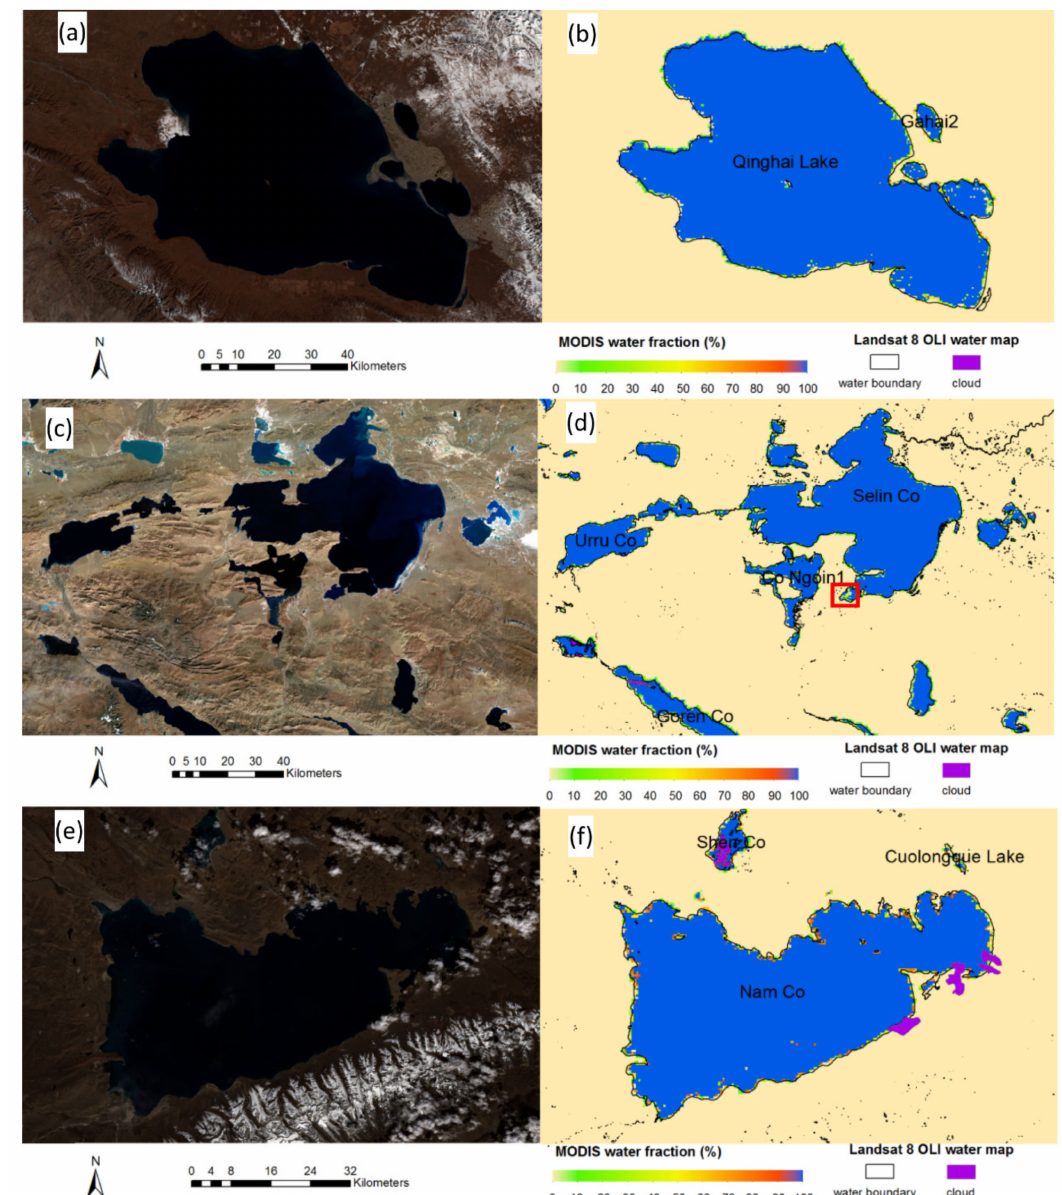
Figure 3. Example of the false color composite Landsat 8 OLI imagery and the comparison of water map from OLI / MODIS pairs no. 1–3 for Qinghai Lake, Selin Co Lake, and Nam Co Lake: ( a ), ( c ), and ( e ) false color composite from OLI image no. 1, 2, and 3, respectively; ( b ), ( d ), and ( f ) comparison of water map from OLI / MODIS pairs no. 1, 2, and 3 corresponding to (a), (c), and